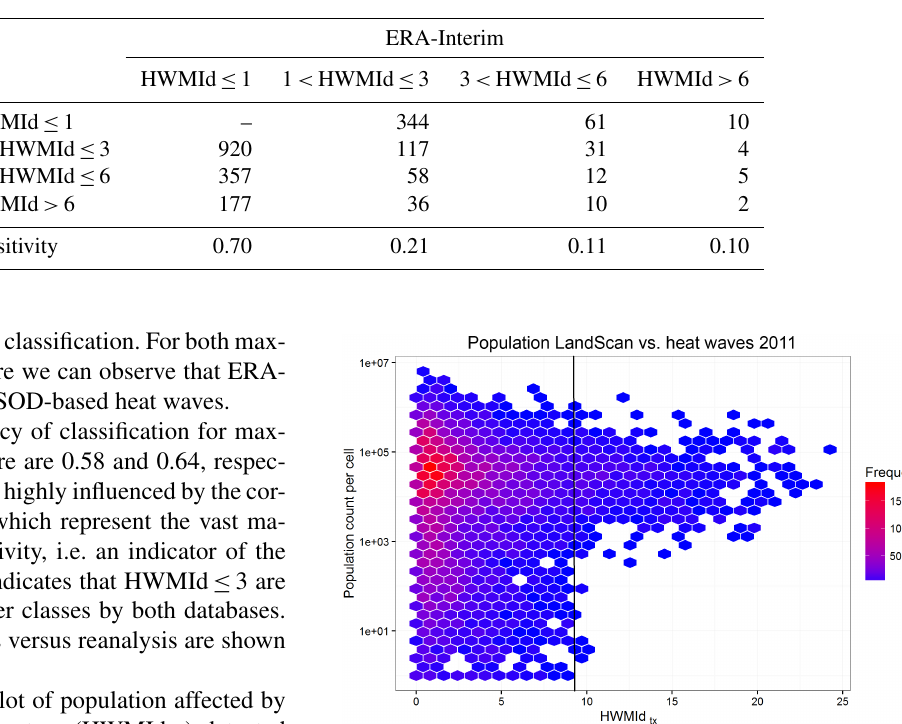
Table 2. Confusion matrix of heat wave detection from observation (GSOD) and reanalysis (ERA-Interim) for minimum temperature for the period 1981–2015.